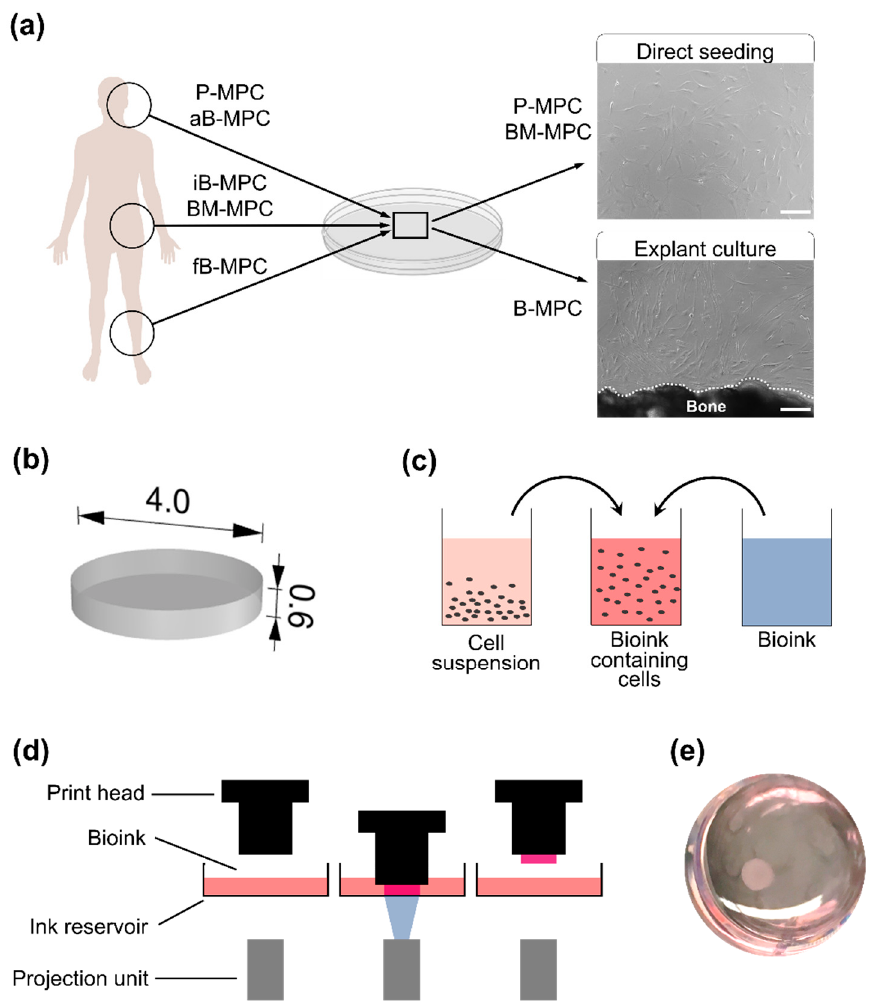
Figure 1. Experimental setup. ( a ) Human mesenchymal progenitor cells were isolated from different body tissues (alveolar bone (aB-MPC), fibula bone (fB-MPC), iliac crest bone (iB-MPC), iliac crest bone marrow (BM-MPC), periosteum of the mastoid (P-MPC)). Scale bar = 200 µm. ( b ) A 3D model was designed with computer-assisted design (CAD) software and exported as an stereolithography (STL) file. Measurements are given in mm. ( c ) Preparation of bioink prior to bioprinting. ( d ) The bioprinting process. The print head is lowered into the ink reservoir and the bioink is solidified by projecting photomasks. ( e ) A photograph showing the completed print in a culture plate.